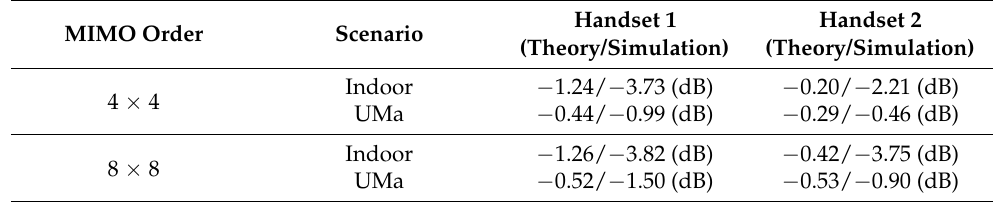
Table 4. SM efficiencies (dB) of two types of terminal MIMO antennas.